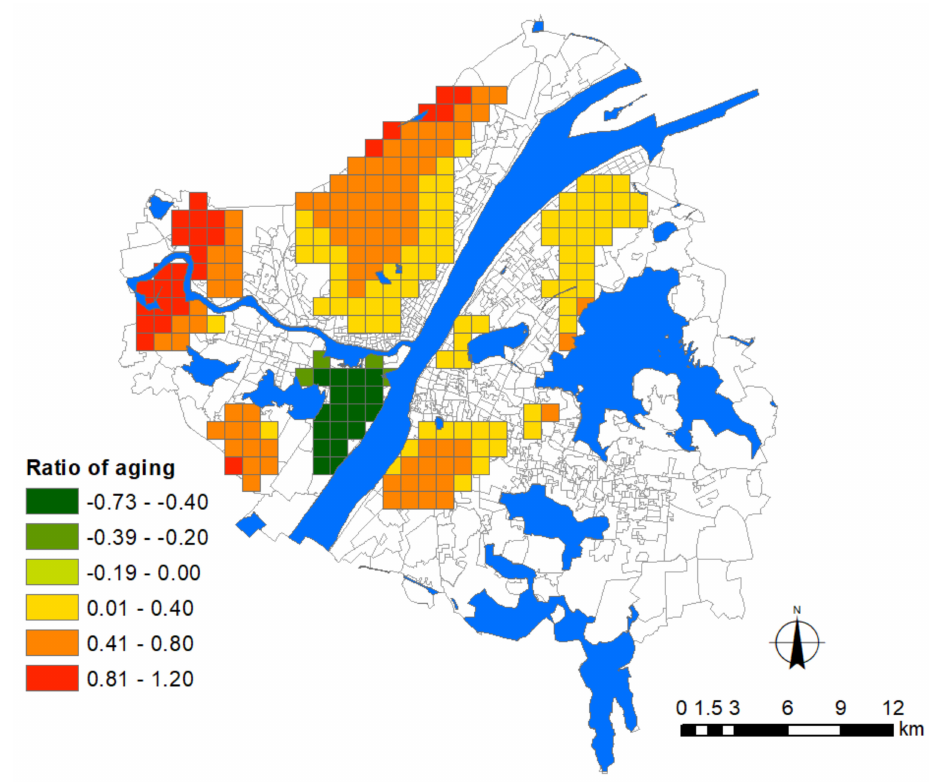
Figure 10. Areas significantly a ff ected by the ration of aging population. The legend denotes the corresponding intensity of